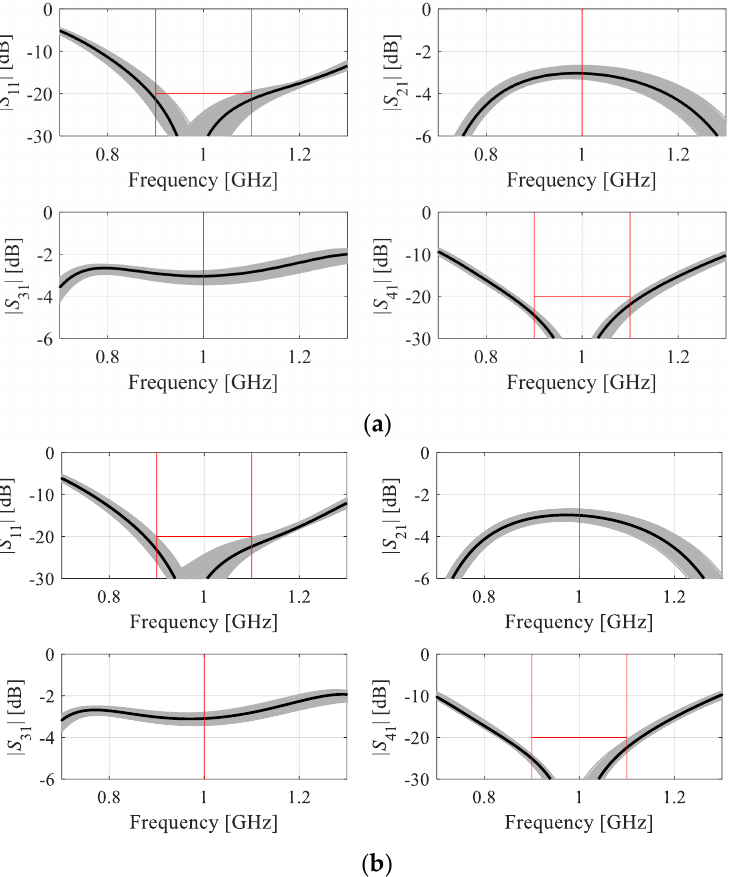
Figure 12. Monte Carlo analysis of the coupler of Figure 10 using EM simulations (gray plots): ( a ) nominal design; ( b ) yield-optimized design obtained using the algorithm of Section 3.2. Black plots show the antenna response at the nominal and the optimized designs, respectively.